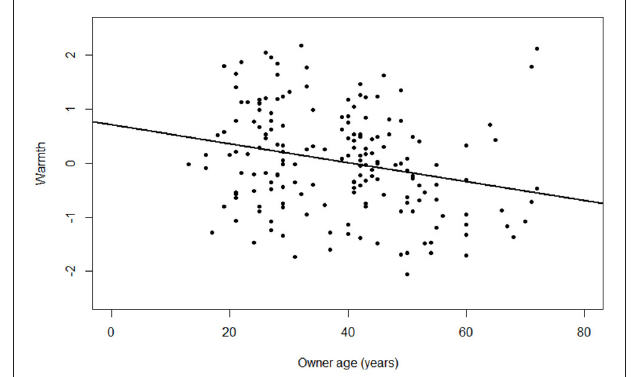
FIGURE 1 | Relationship between the factor “ Owner Warmth ” and the owner age (expressed in